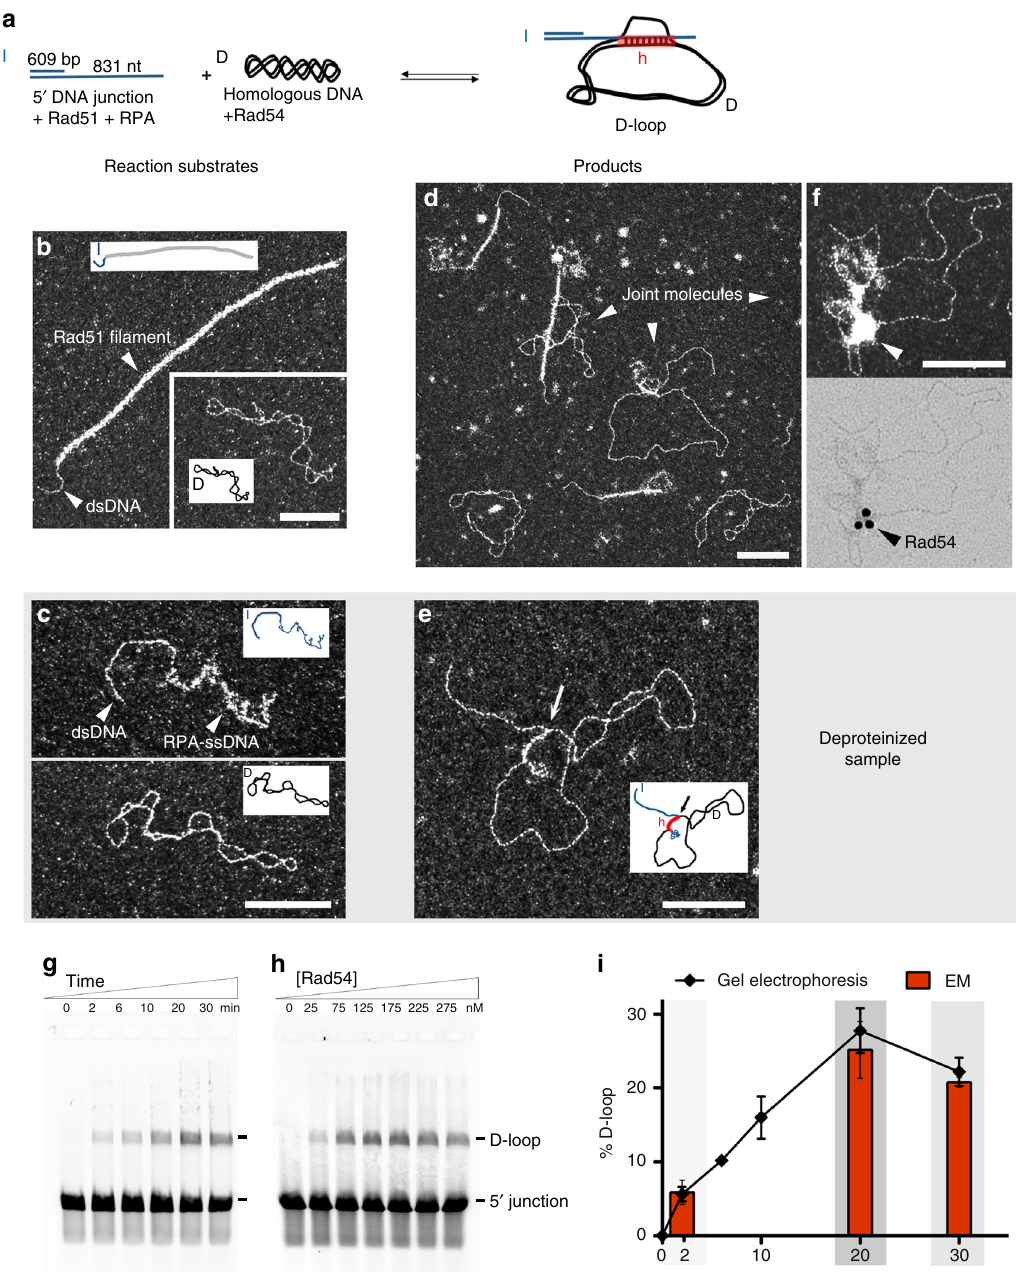
Fig. 1 D-loop assay by electron microscopy (EM) and by gel electrophoresis. a Scheme of the D-loop assay. b Representative EM images of the reaction substrates with insets of schematic drawings of the molecules: the Rad51 fi lament formed on 5´ DNA junction and the homologous supercoiled DNA. c Reaction substrates in the deproteinized samples suitable for EM analysis: 5´ DNA junction with 3´ ssDNA part covered with RPA (top), supercoiled homologous DNA donor (middle). d EM representative view of the D-loop reaction after 20 min incubation with homologous DNA and Rad54. e D-loop observed in the deproteinized sample, with an arrow pointing to the synaptic contact between molecules (bottom). For additional images see Supplementary Fig. 2a. f Imunolabeling of Rad54 in the D-loop reaction using rabbit anti-Rad54 primary antibody and immunolabeled anti-rabbit secondary antibody followed with DNA-protein complexes puri fi cation. The same joint molecule is imaged using dark- fi eld mode in the top image while using bright fi eld (bottom image) allowing the detection of the gold beads. Seven 1% of labeled joint molecules where counted ( n = 2, 100 molecules each). g D-loop assay time course after donor DNA addition using 175 nM of Rad54 h D-loop assay with Rad54 titration in 20 min reactions. D-loop yield peaks at 175 nM of Rad54, which corresponds to 7 Rad54 proteins per invading or donor dsDNA molecule. i Graph of data in c (line plot, from electrophoresis gel quanti fi cation, n = 5) and from the EM quanti fi cation (red bars plot, at three time points: 2, 20, and 30 min. n = 3, 300 molecules each). Error bars indicate standard deviations. Gray shading corresponds to the three time points chosen for further experiments. In all EM pictures, the white bar represents 100 nm. In a , d : I invading strand (blue), D donor DNA (black), and h heteroduplex (red). Source data are provided as a Source Data fi